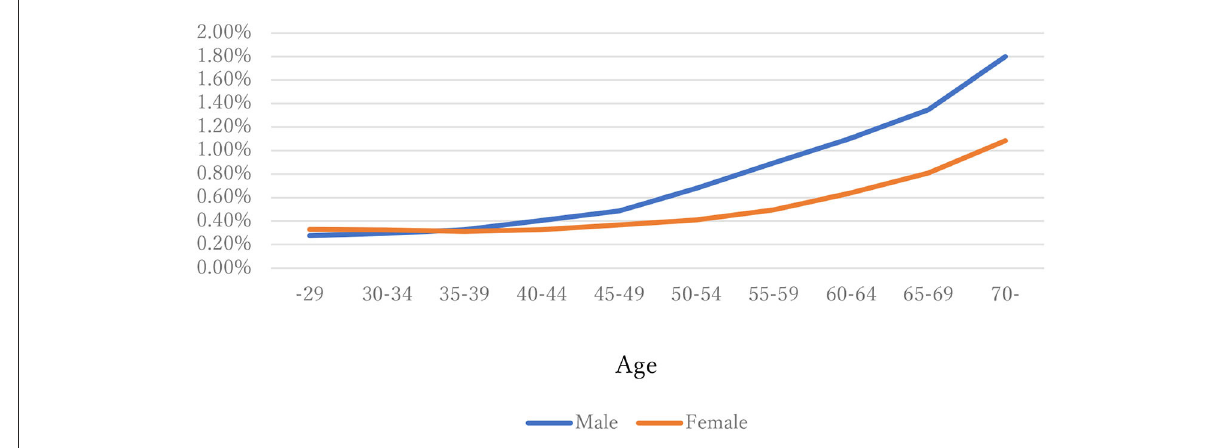
FIGURE2 The percentages of having HD by next year by age and gender.